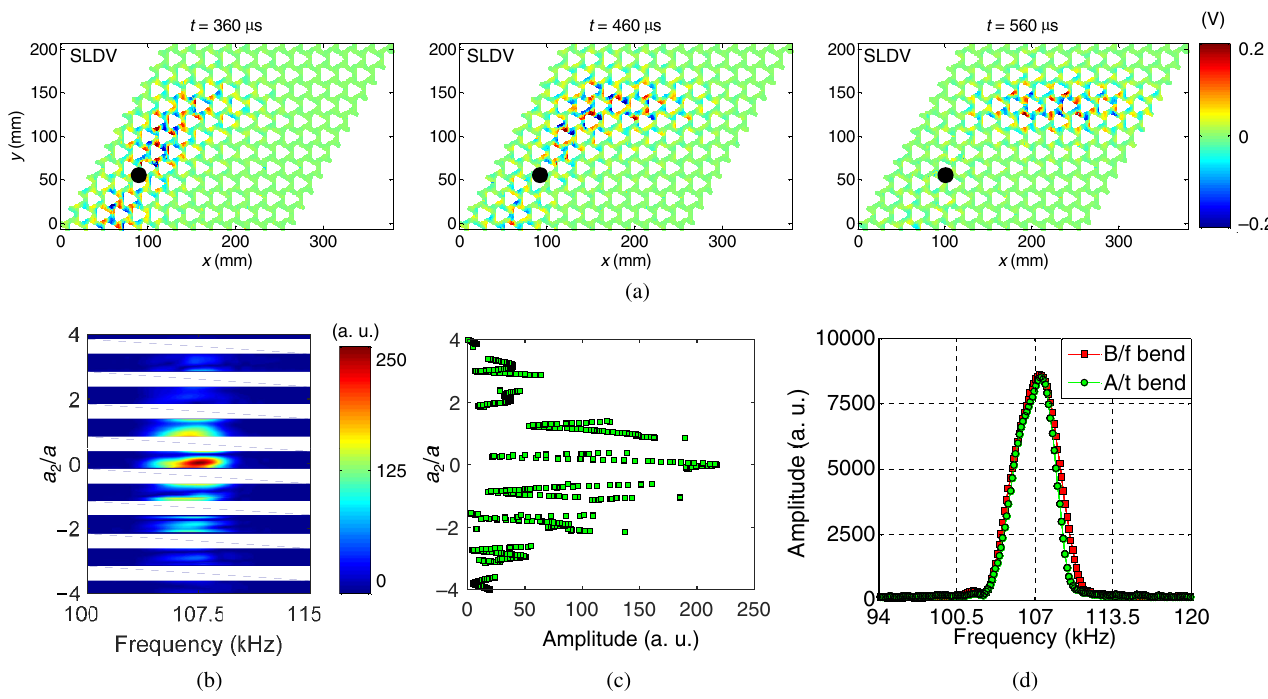
FIG. 5. Immunity to backscattering of the helical edge waves along the Z -shaped interface. (a) Experimental wave-field measurements showing the right-propagating edge mode traversing the turn in the top-right portion of the plate [the domain of measurements is denoted as “ 2D large scan ” in Fig. 1(d)]. The time snapshots show the out-of-plane velocity before the wave approaches the turn (at t ¼ 360 μ s) and demonstrate how the nontrivial interface supports the propagation past the 120° bend without backscattering ( t ¼ 460 μ s) while sustaining propagation after the Z bend ( t ¼ 560 μ s). The colors, varying from blue to red, correspond to the out-of-plane velocity of the plate (1 V corresponds to a velocity of 20 mm = s). (b) Experimental amplitude profile across the interface for the right-propagating edge mode as a function of the frequency. Signals are acquired along a line in the a 2 direction, transverse to the domain wall in the top part of the waveguide [see yellow square dots in Fig. 1(d)]. (c) Spectral amplitude at f ¼ 107 kHz as a function of the distance from the interface. (d) Comparison of amplitudes of the 1D-FT averaged over 1D scan lines of the same length located before and after the upper sharp bend of the waveguide, quantitatively illustrating the absence of backscattering or mode conversion after the 120° bend. The SLDV sensitivity is set to 20 mm = s = V for all the measurements